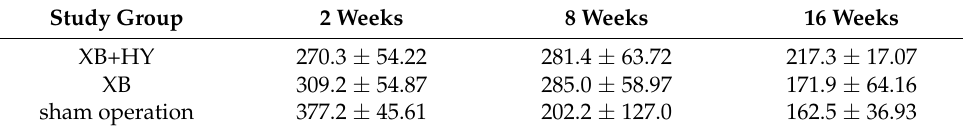
Table 7. Vessel densities within the calvarial defect sites of the different study groups (vessels/mm 2 ).